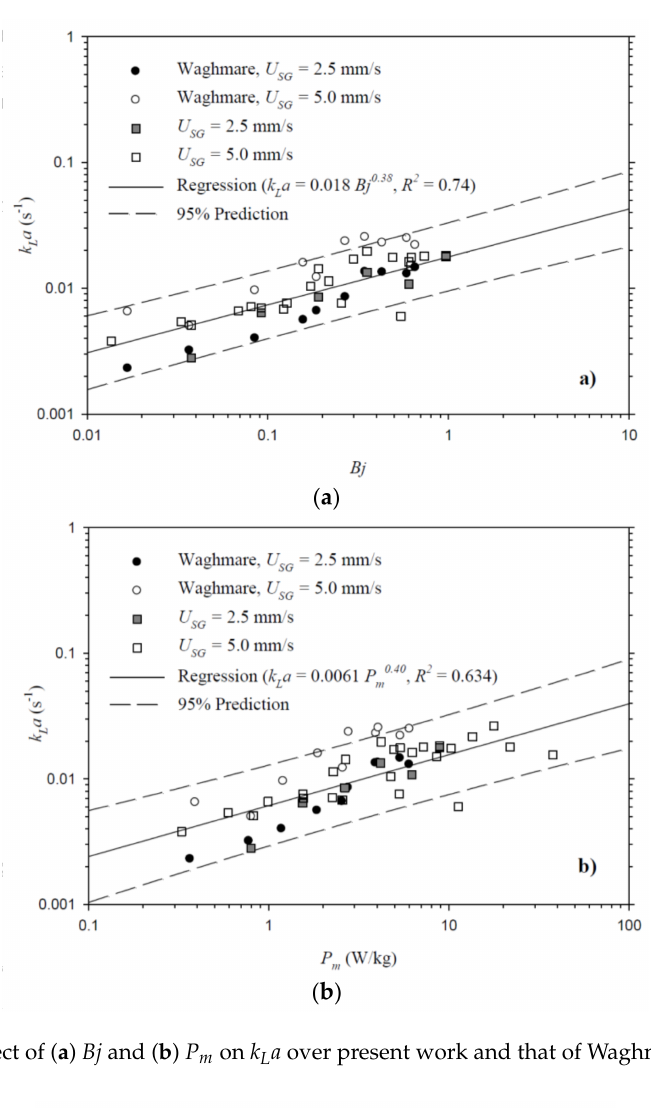
Figure 19. Effect of ( a ) Bj and ( b ) P m on k L a over present work and that of Waghmare et al. [19].